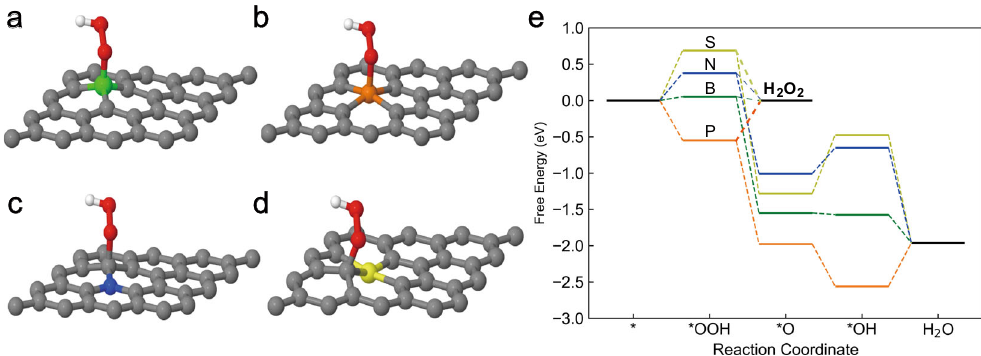
Fig. 3 Preferred *OOH adsorption con fi gurations and free-energy pro fi le by DFT studies. a – d Preferred *OOH adsorption con fi gurations on B-, P-, N-, and S- doped graphene, respectively. Green, orange, blue, yellow, gray, red, and white spheres represent boron, phosphorous, nitrogen, sulphur, carbon, oxygen and hydrogen, respectively. e Free-energy pro fi le of O 2 reduction paths where each state ’ s charge is corresponding to the potential of U RHE = 0.7 V (Supplementary Fig. 19).